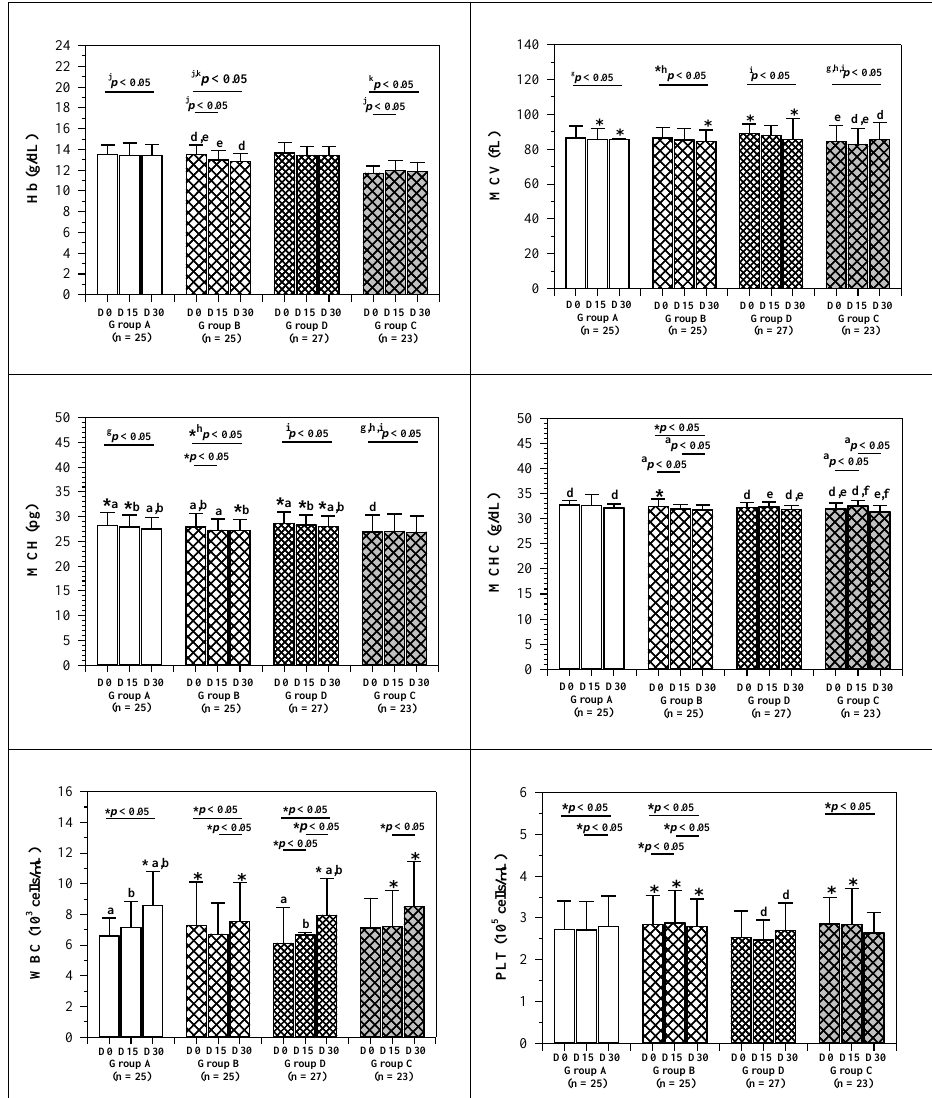
Figure 3. Changes in RBC indices, WBC and platelet numbers of elderly subjects. Non-anemic subjects consumed the WR drink (2 mg iron/100 mL serving) (group A), IR drink (15 mg iron/100 mL serving) (group B) and IR drink (27 mg iron/100 mL serving) (groups D), and anemic subjects consumed the IR drink (15 mg iron/serving) (group C) for 30 days and blood samples were collected for complete blood count analysis. Data are expressed as mean ± SD values. * Comparisons of results of Shapiro – Wilk test ( p < 0.05). d,e,f Between D0 and D15, D0 and D30, D15 and D30 for normal distribution by paired Student’s t -test ( p < 0.05) after using repeated analysis of variance (repeated ANOVA) ( p < 0.05). a,b,c Comparisons between D0 and D15, D0 and D30 and D15 and D30 for non-normal distribution were performed by the Wilcoxon signed rank test ( p < 0.05) after using the Friedman test ( p < 0.05). j,k,l Bonferroni test ( p < 0.05) among groups with normal distri- bution data after using one-way analysis of variance (one-way ANOVA) test. g,h,i Comparisons of Kruskal – Wallis test ( p < 0.05) for four groups and Dunn test ( p < 0.05) between two groups with non-normal distribution data. Abbreviations: EOS = eosinophil, Hb = hemoglobin, Hct = hematocrit, Lym = lymphocyte, MCH = mean corpuscular hemoglobin, MCHC = mean corpuscular hemoglobin, MCV = mean corpuscular volume, Mon = monocytes, PLT = platelet, PMN = polymorpho- nuclear cell, RBC = red blood cells, WBC = white blood cells.